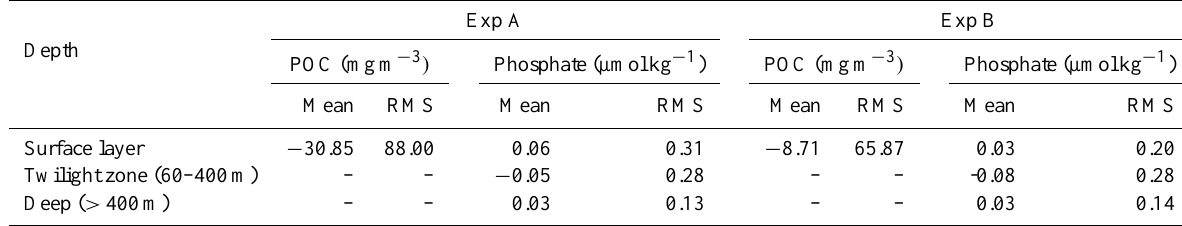
Table 4. Mean and RMS of phosphate and POC model–data misfits for Exp A and Exp B.